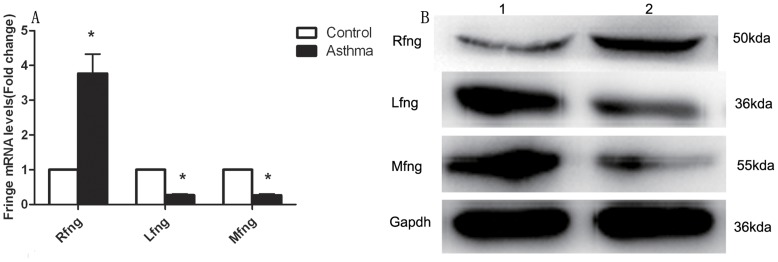
Expression of three Fringe homologes on naïve CD4+T lymphocytes.
A, The mRNA expression levels of Rfng, Lfng and Mfng on naïve CD4+T lymphocytes were determined by Q-PCR, normalized to GAPDH. Results are from three independent experiments and the results for each group are expressed as mean±SEM. P<0.05, significant differences comparing asthmatic group and control group. B, Western blot was performed to detect the protein levels of Rfng, Lfng and Mfng (1, control group; 2, asthmatic group).